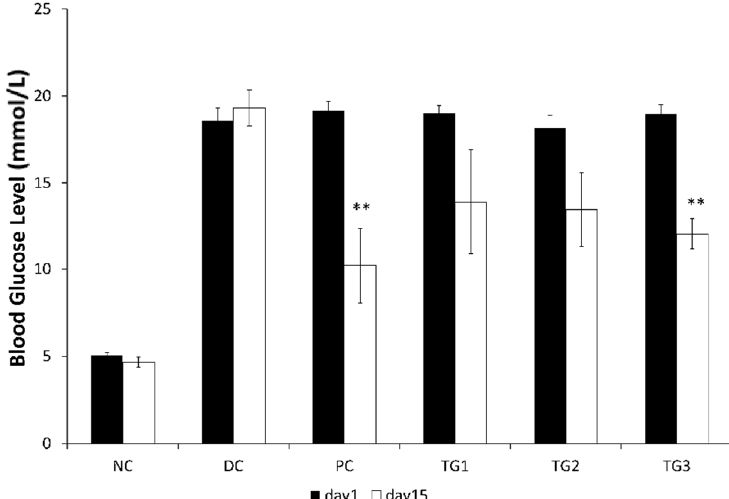
Figure 4. Comparing blood glucose levels before and after 14 days of treatment with Gongronema latifolium extract. Values are expressed as the mean ± SEM, ** = p < 0.01.